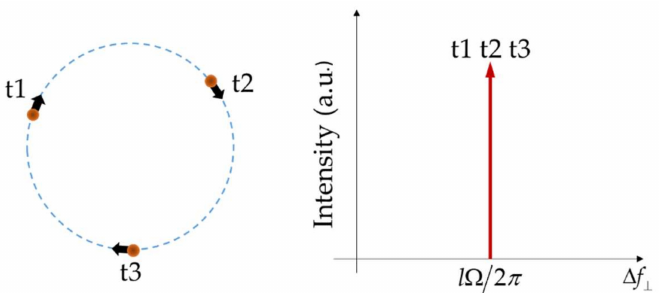
Figure 2. Target rotates with angular velocity Ω and a time-independent (t 1 , t 2 , t 3 represent three different times) Doppler shift of value l Ω /2 π appearing in the scattered vortex